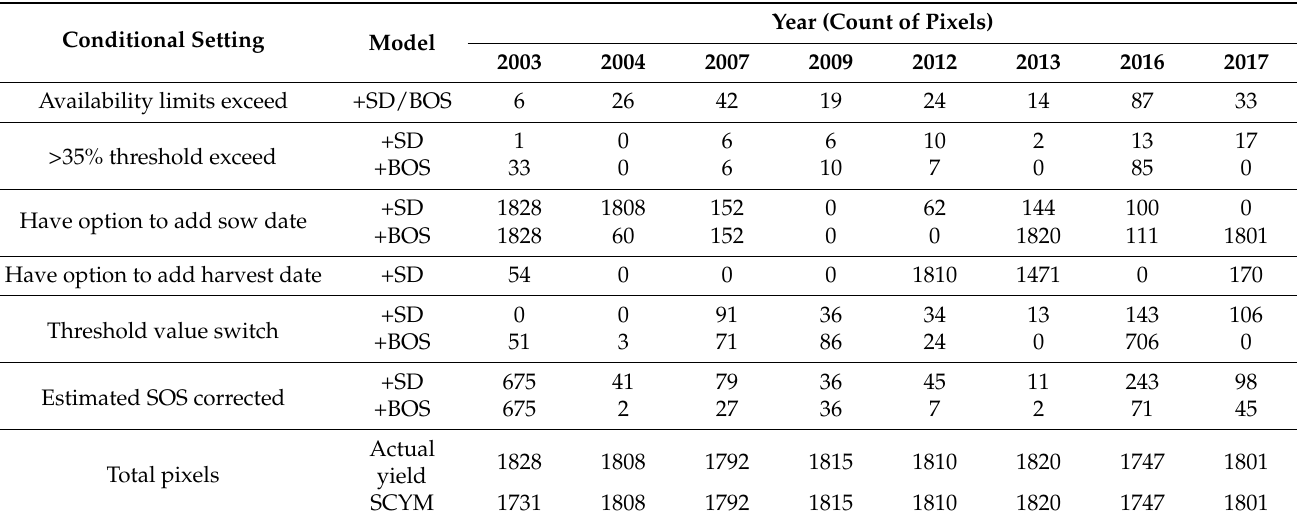
‘Conditional setting’ is described in Figure 3. ‘Estimated SOS changed’ refer to the pixels where the SOS date estimated using statistical phenology detection (SPD) is earlier than the farmer-reported sowing date but has been corrected to be later than the farmer-reported sowing date in the +SD or +BOS